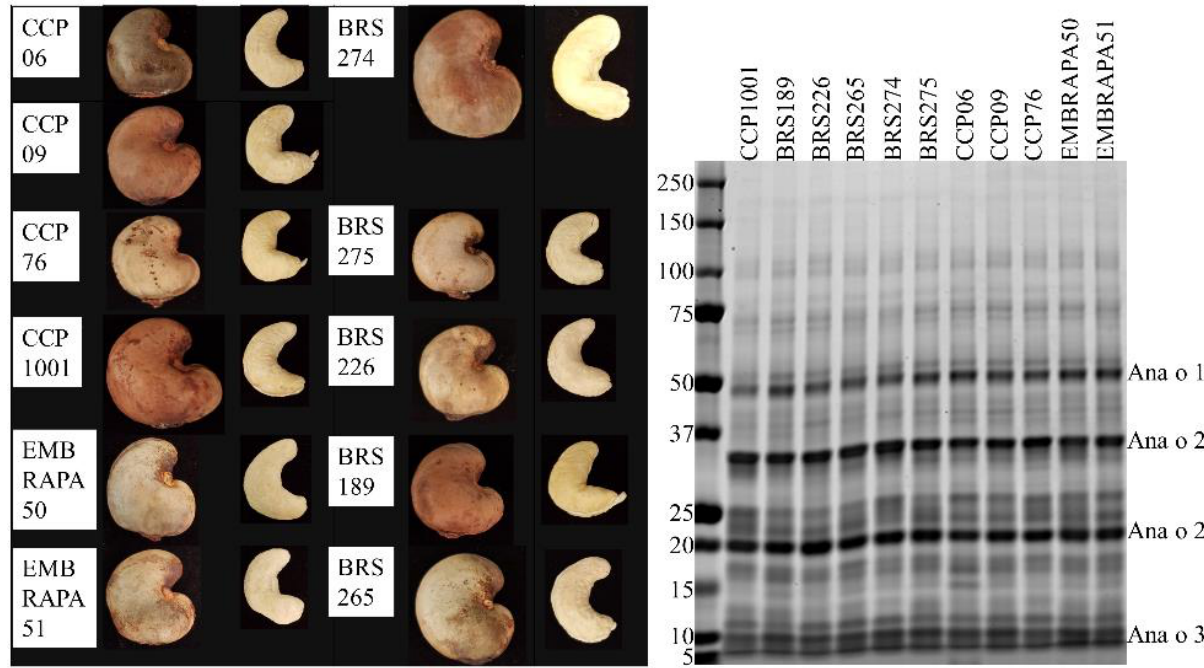
Figure 6. Representative images of unshelled and shelled cashew nuts collected from each cultivar ( left panel ). SDS-PAGE analysis of protein extracts (4 µg) from Brazilian cashew nut cultivars ( right panel ). Molecular weight standards (in kDa) are shown vertically to the left of the gel.